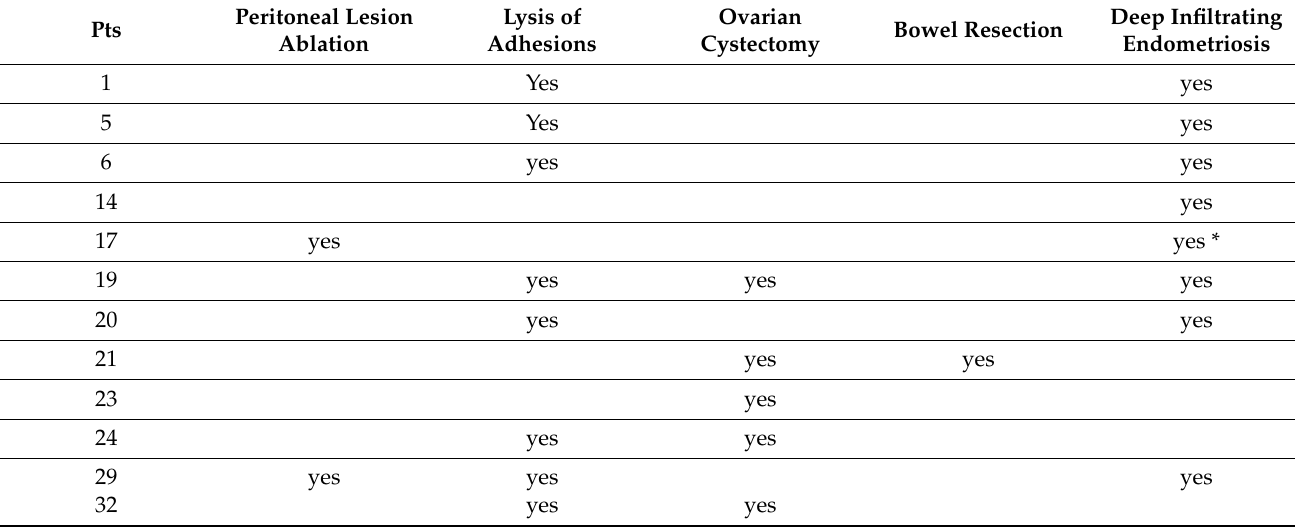
Table 2. Surgical procedures performed in laparoscopy in pelvic